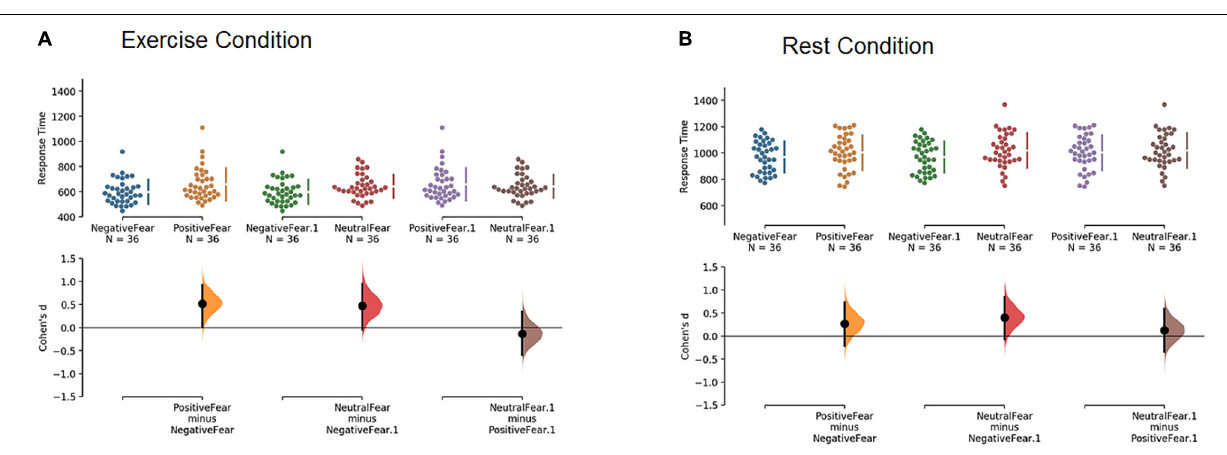
FIGURE 3 | Cumming estimation plots and Cohen’s d on response time for the effect of the affective primes on fearful faces only, in exercise (A) and rest (B)